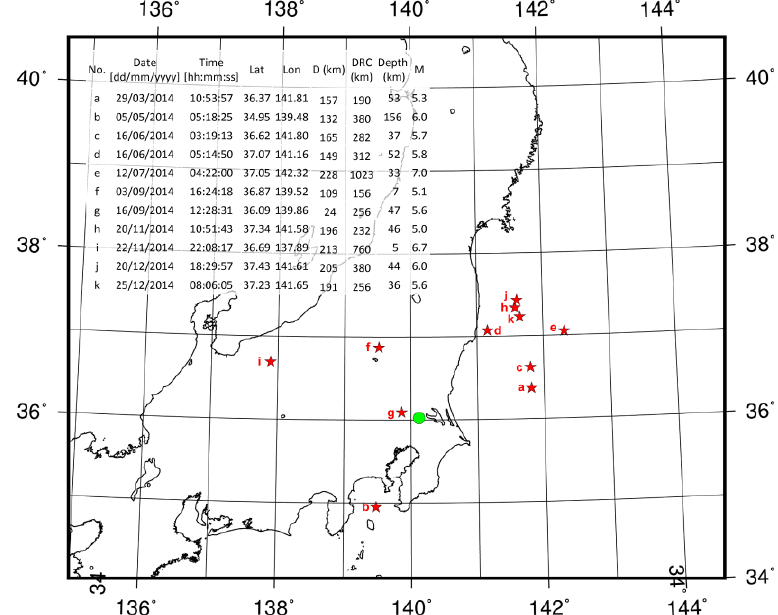
Figure 5. The detail of earthquakes which occurred during the days exceeding effective magnitude (Meff) 5.0. The red stars represent the locations of earthquakes. The green circle represents the location of the farm used to observe milk yields. The upper table shows the detail of earthquakes. The alphabets in the map correspond with those in the table. Lat = Latitude; Lon = Longitude; D = Distance from epicenters; DRC = Dobrovolsky radius condition. Animals 2017 , 7 , 19